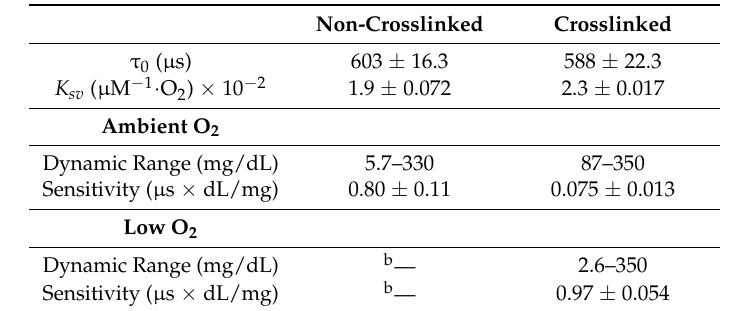
Table 1. Figures of merit calculated for AnA hydrogels with and without crosslinked microparticles at ambient and low oxygen conditions a